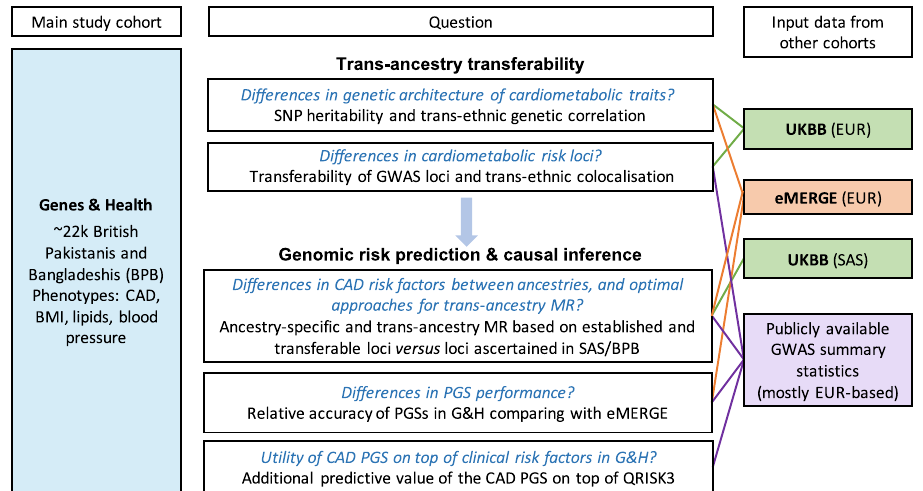
Fig. 1 | Summary of study design, research questions and analyses conducted. The coloured boxes indicate input data. Within the white boxes, the black text indicates the analyses we used to address the questions in blue. BPB British Pakistanis and Bangladeshi ancestry, EUR European ancestry, SAS South Asian